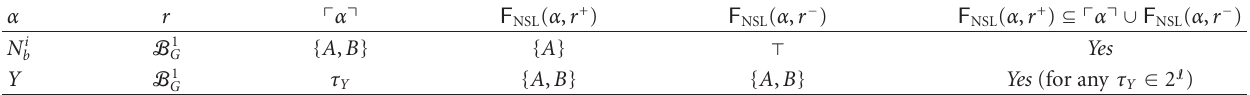
Table 9: Analysis of NSL protocol: role of B